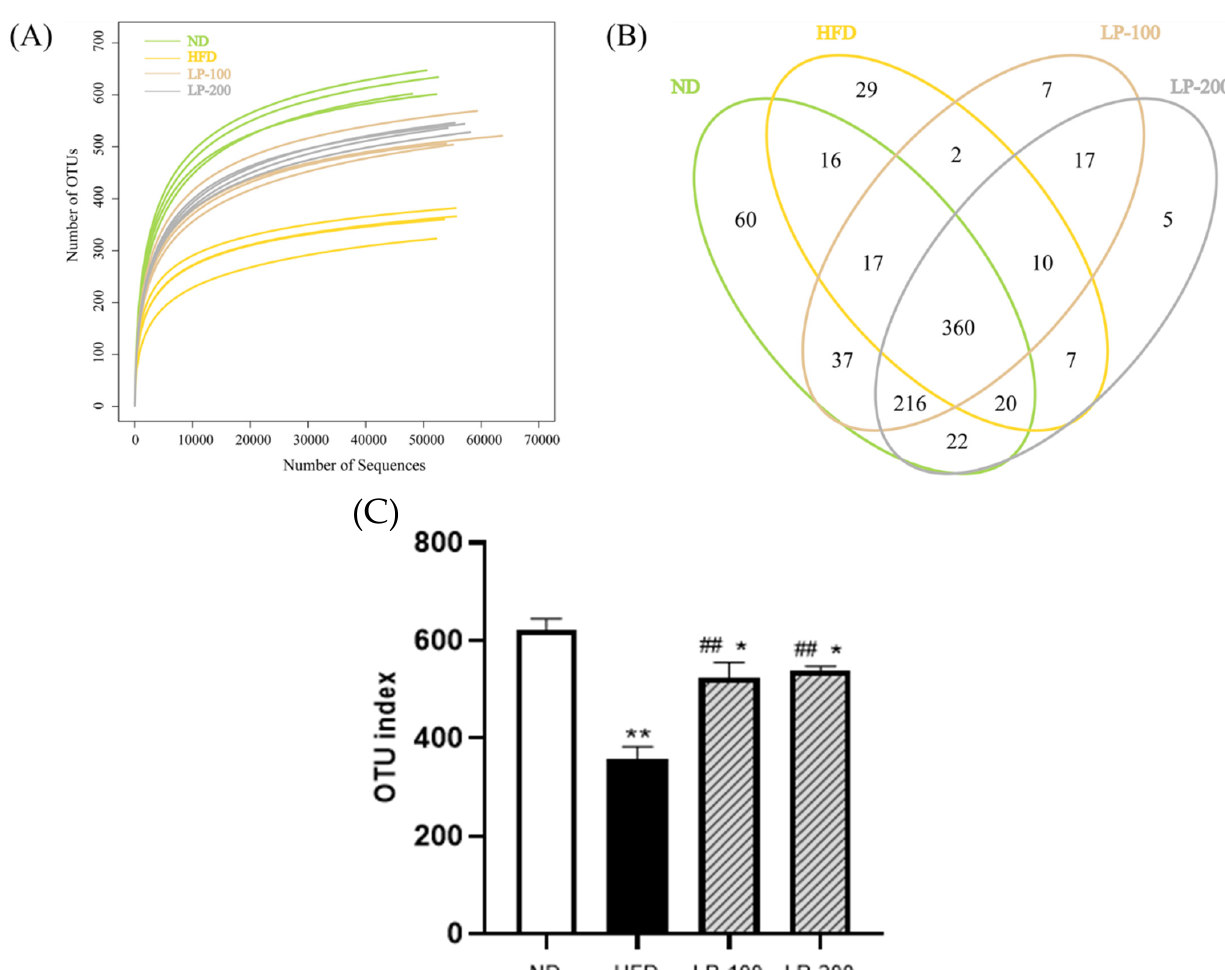
Figure 4. Dilution curves ( A ), Venn diagram ( B ), and OTU index ( C ) of intestinal flora samples in each group. * p < 0.05, ** p < 0.01 vs. ND group; ## p < 0.01 vs. HFD group.